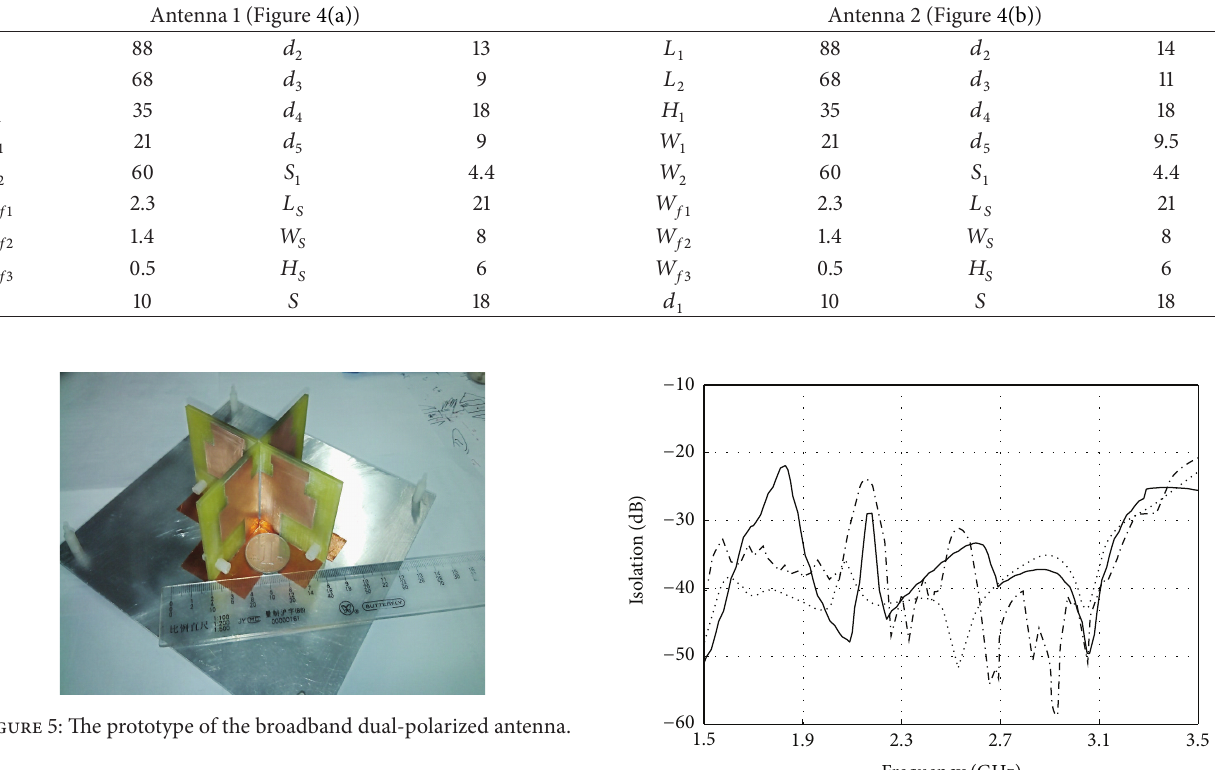
Table 2: Dimensions of the dual-polarized printed dipole antenna (unit: mm).